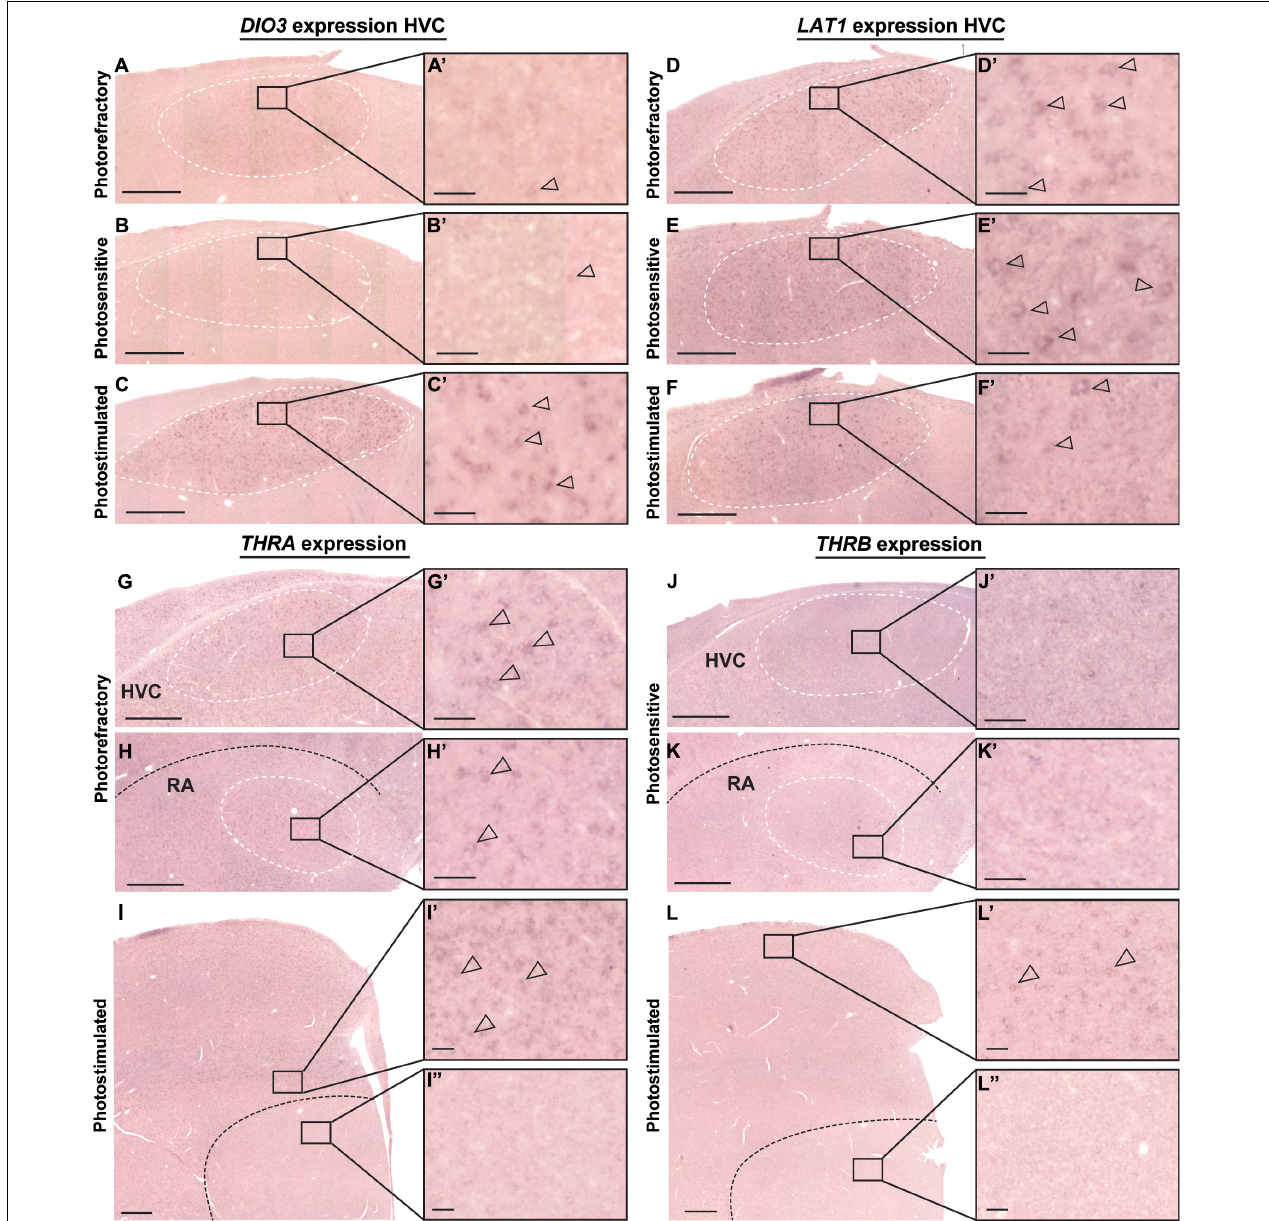
FIGURE 3 | Representative images of DIO3 (A–C) , LAT1 (D–F) , THRA (G–I) , THRB (J–L) mRNA expression in the starling brain. DIO3 and LAT1 mRNA expression changes seasonally over the photorefractory (A,D) , photosensitive (B,E) , and photostimulated phase (C,F) . THRA and THRB mRNA expression remain unchanged during the different seasons in caudal telencephalon (G,H,J,K) at the level of HVC (G,J) and RA (H,K) and in the rostral telencephalon (I,L) at the level of LMAN (I’) , pallium (L’) , and Area X (I”, L”) . The inserts indicate the location of the close-ups (A’–L’) . The borders of HVC and RA are designated by white dashed lines. Black dashed line indicates the border between nidopallium and arcopallium in panels (H,K) and the border between striatum and pallium in panels (I,L) . Empty arrowheads designate examples of DIO3 +, LAT1 +, and THRA + cells respectively. Scale bar in overview and inset pictures are 500 and 50 µ m,